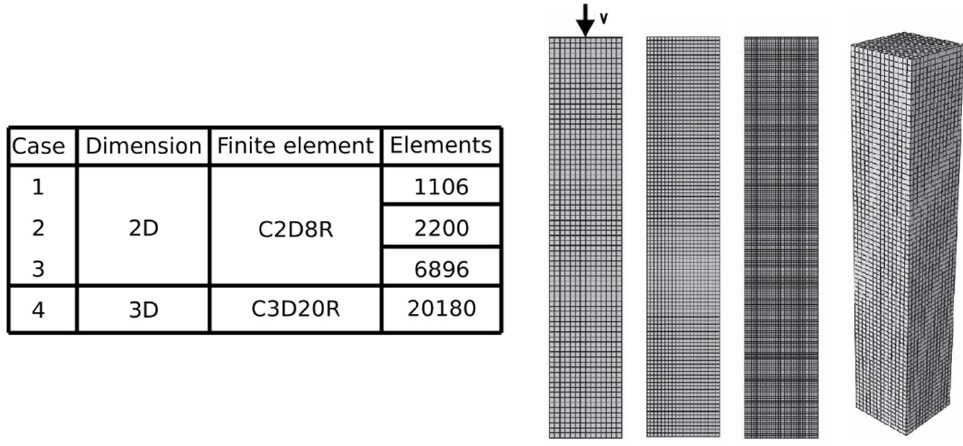
Figure 7. Main aspect features and meshes used in the convergence